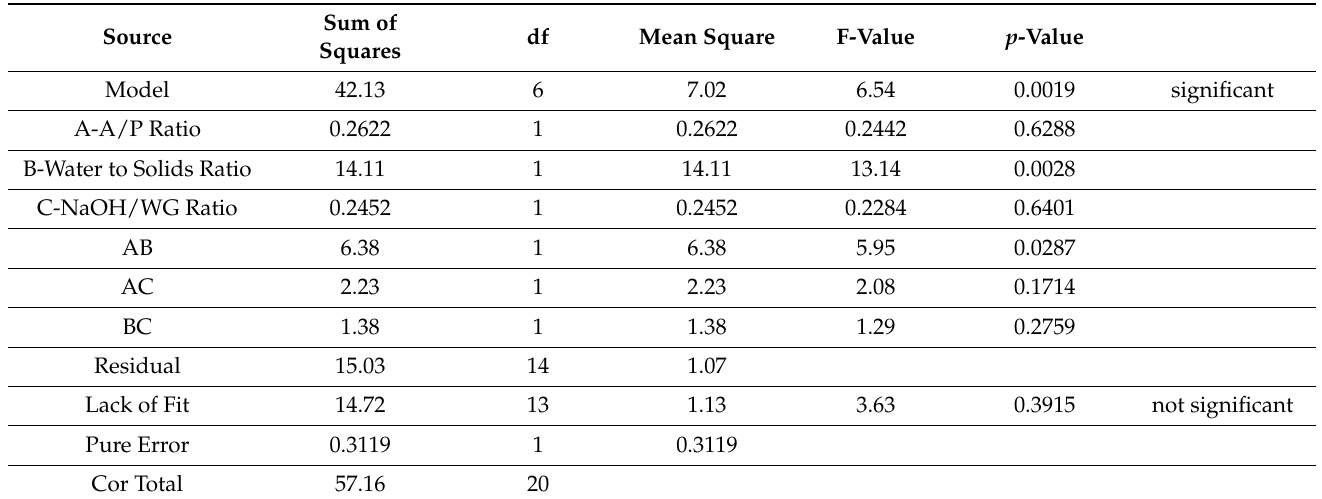
Table 10. ANOVA for reduced 2FI model (Response 2: final setting time).